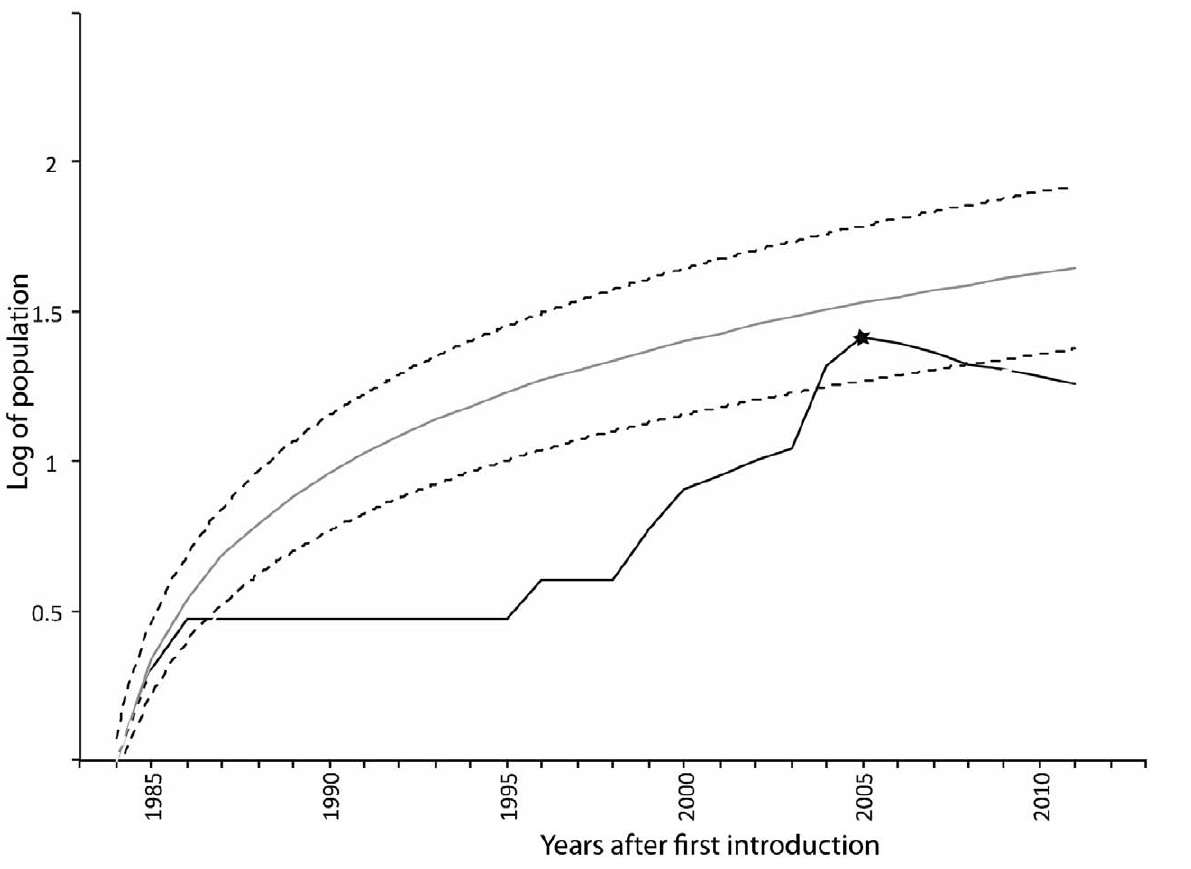
Figure 6. Topmouth gudgeon Pseudorasboraparva invasion. Predicted populations (grey line; y=0.417ln(x) + 0.2461; R 2 =0.97) based on European invasion data [23] and 95% confidence interval (dash line). Effective topmouth gudgeon populations detected in the UK during the same period (black line) with the star indicating the start of the national eradication programme.